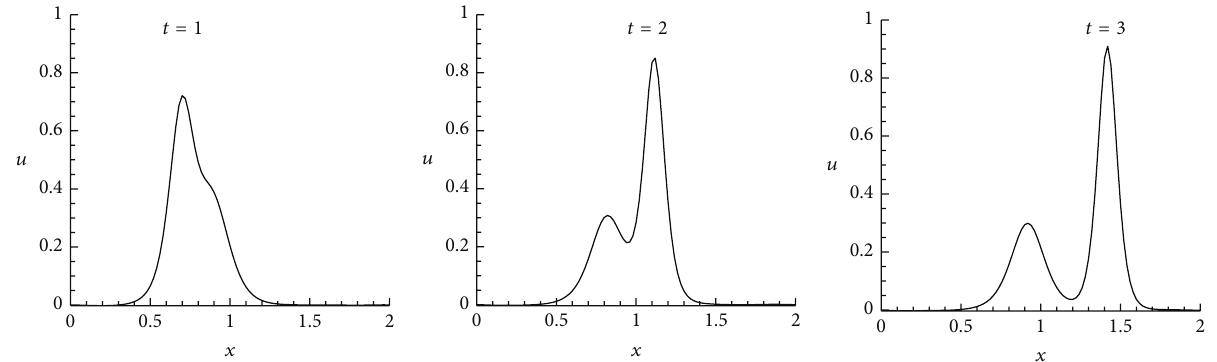
Figure 5: Double soliton solutions for equation 𝑢 𝑡 + 𝑢𝑢 𝑥 + 𝜀𝑢 𝑥𝑥𝑥 = 0 of Example 5 at various time stages.